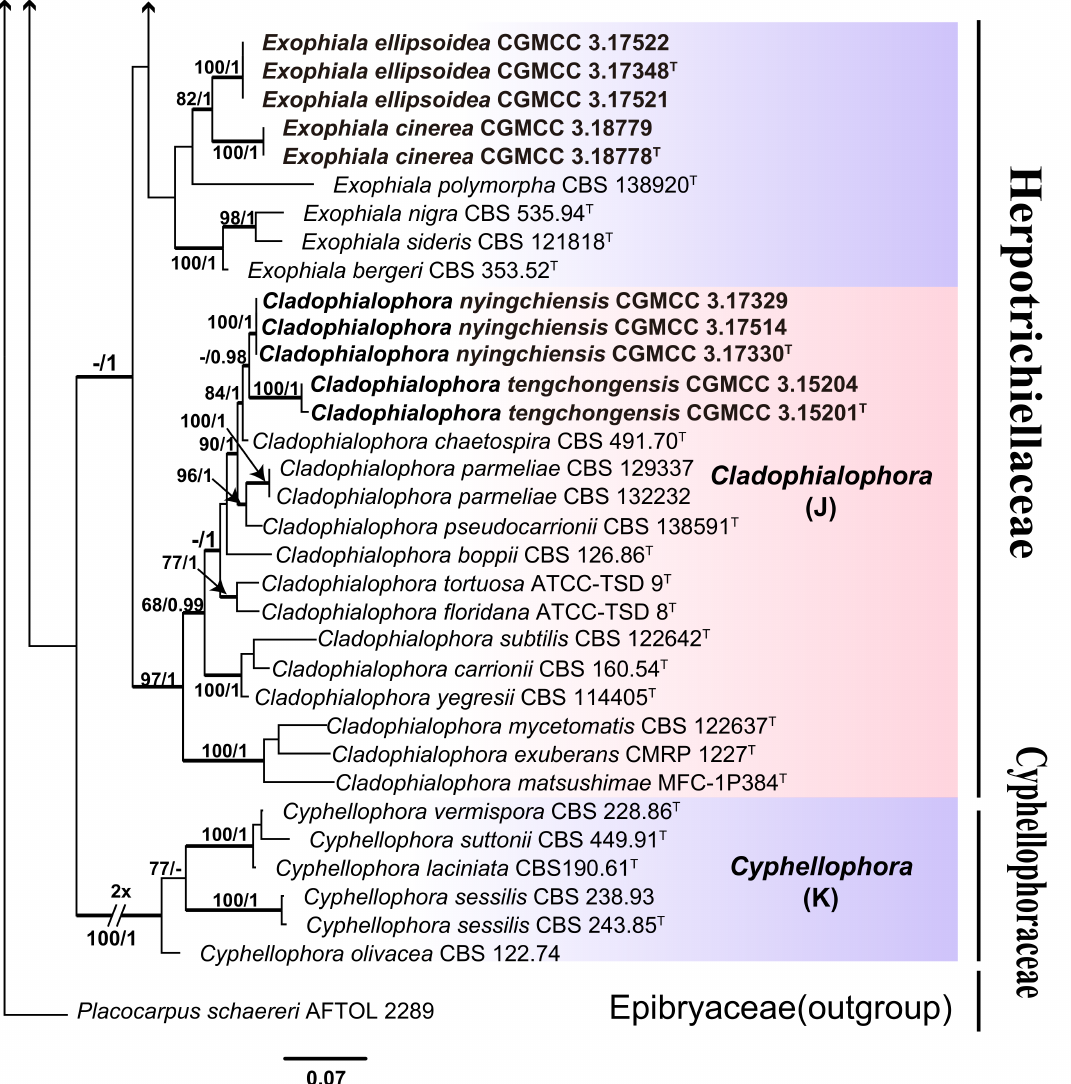
Figure 2. Phylogenetic tree generated by the maximum likelihood analysis using combined sequences of the internal transcribed spacer region (ITS) and partial nuclear ribosomal large subunit (nucLSU) loci of the families Trichomeriaceae and Herpotrichiellaceae. Bootstrap values ≥ 70% ( left ) and Bayesian posteriorprobabilityvalues ≥ 0.95( right )areindicatedatnodes(maximumlikelihood / Bayesianinference or ML / BI). Thickened branches represent posterior probabilities ( > 0.95) from BI. Placocarpus schaereri strain AFTOL 2289 is used as the outgroup. Novel sequences generated in this study are indicated in bold. Ex-type cultures are marked with ” T